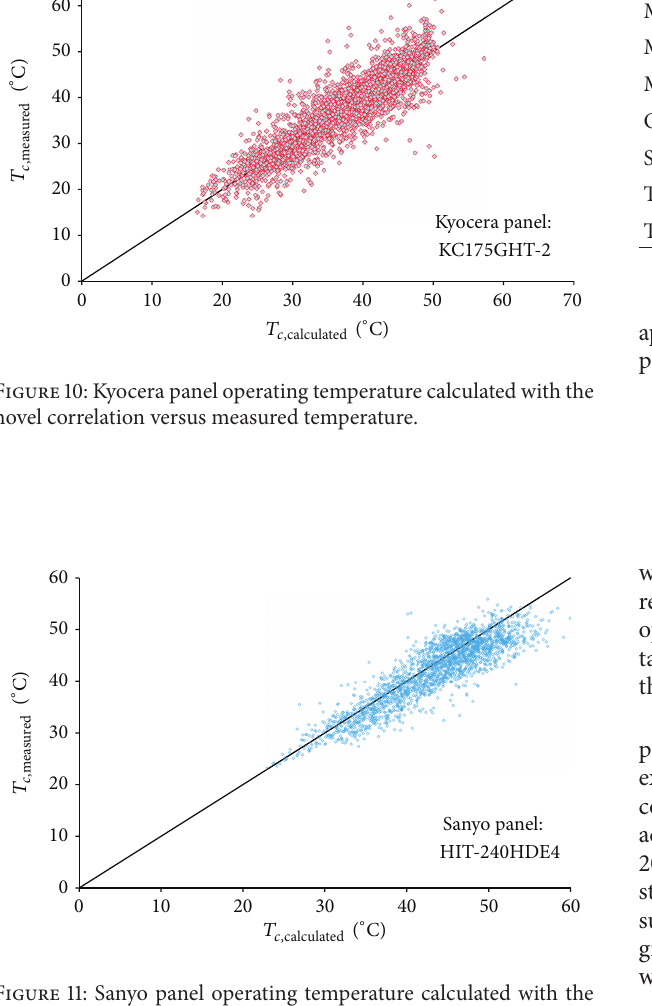
Figure 11: Sanyo panel operating temperature calculated with the novel correlation versus measured temperature.